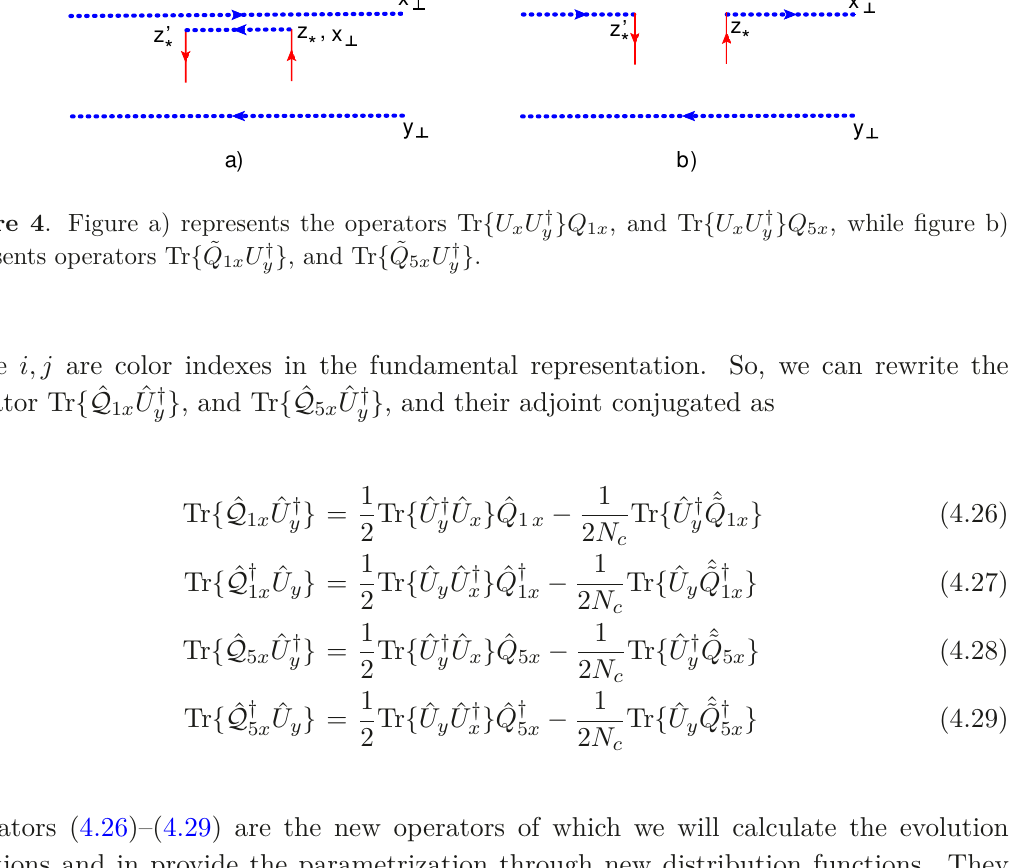
} Q 5 x , while figure b) y